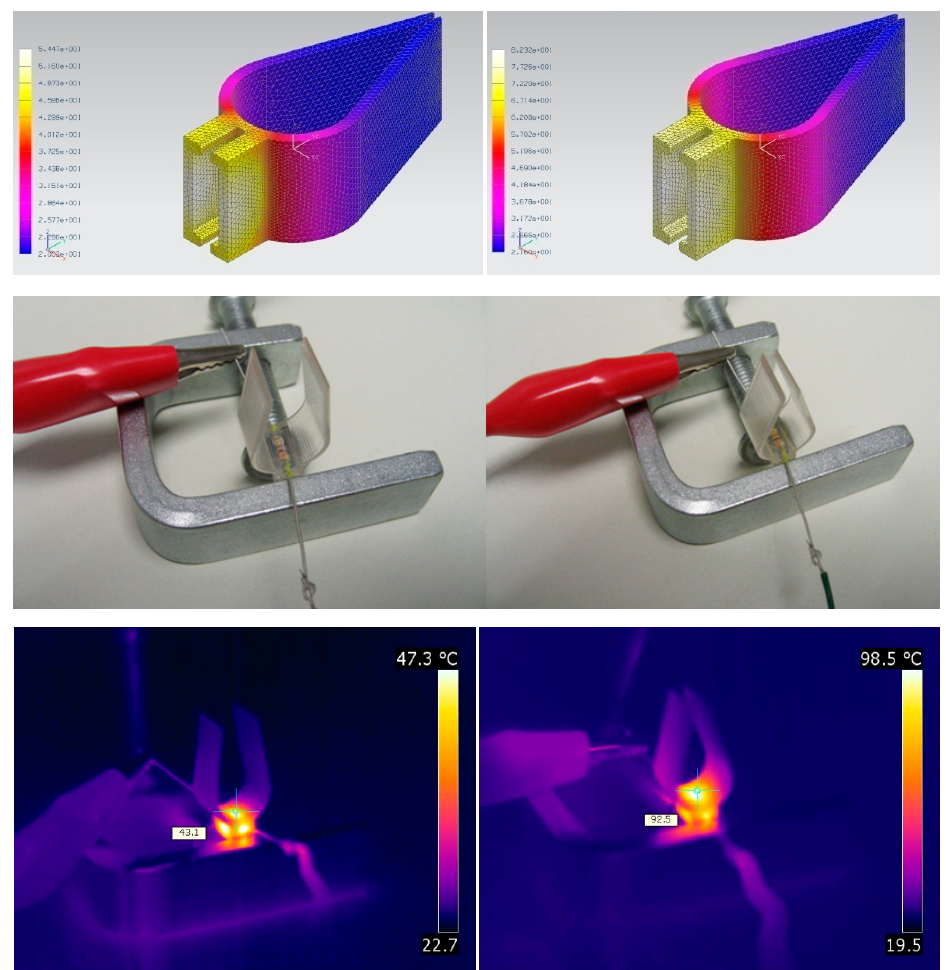
Figure 5. Validation of the activation system of a SMP surgical pincer: Design carried out with the help of thermal finite-element simulations and validation supported by IR-thermography for comparative purposes. See [10,21] for additional details regarding the use of FEM modeling and IR-thermography in the development of smart actuators based on shape-memory polymers.